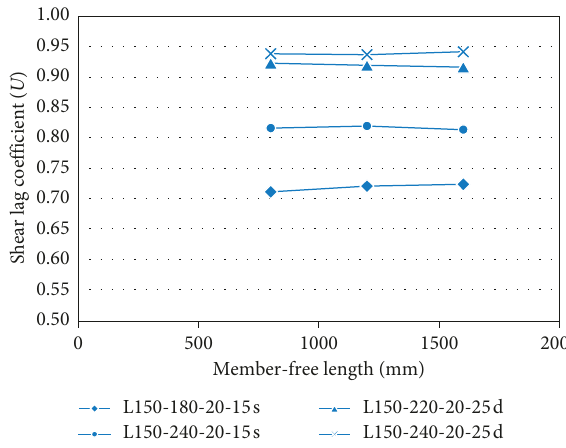
Figure 14: Effect of member-free length on the tension capacity of single and double angles. Table 3: Comparison of the results of numerical analyses with the AISC